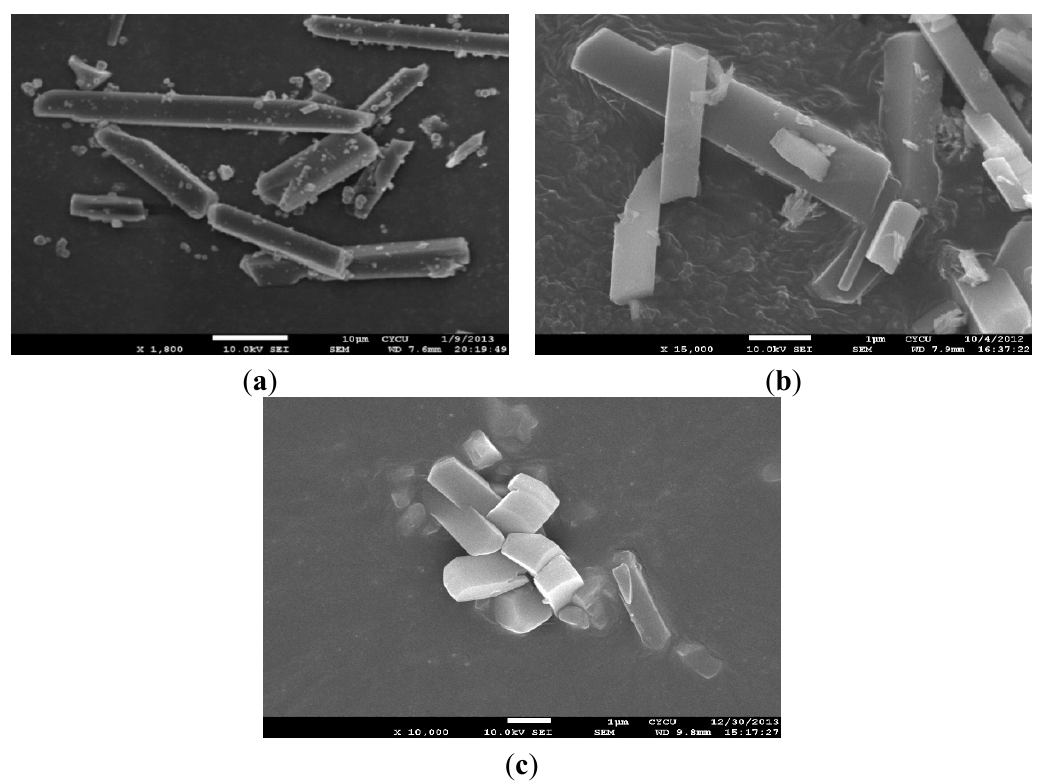
Figure 2. The SEM images of 1 ( a ), 2 ( b ) and 3 ( c ).